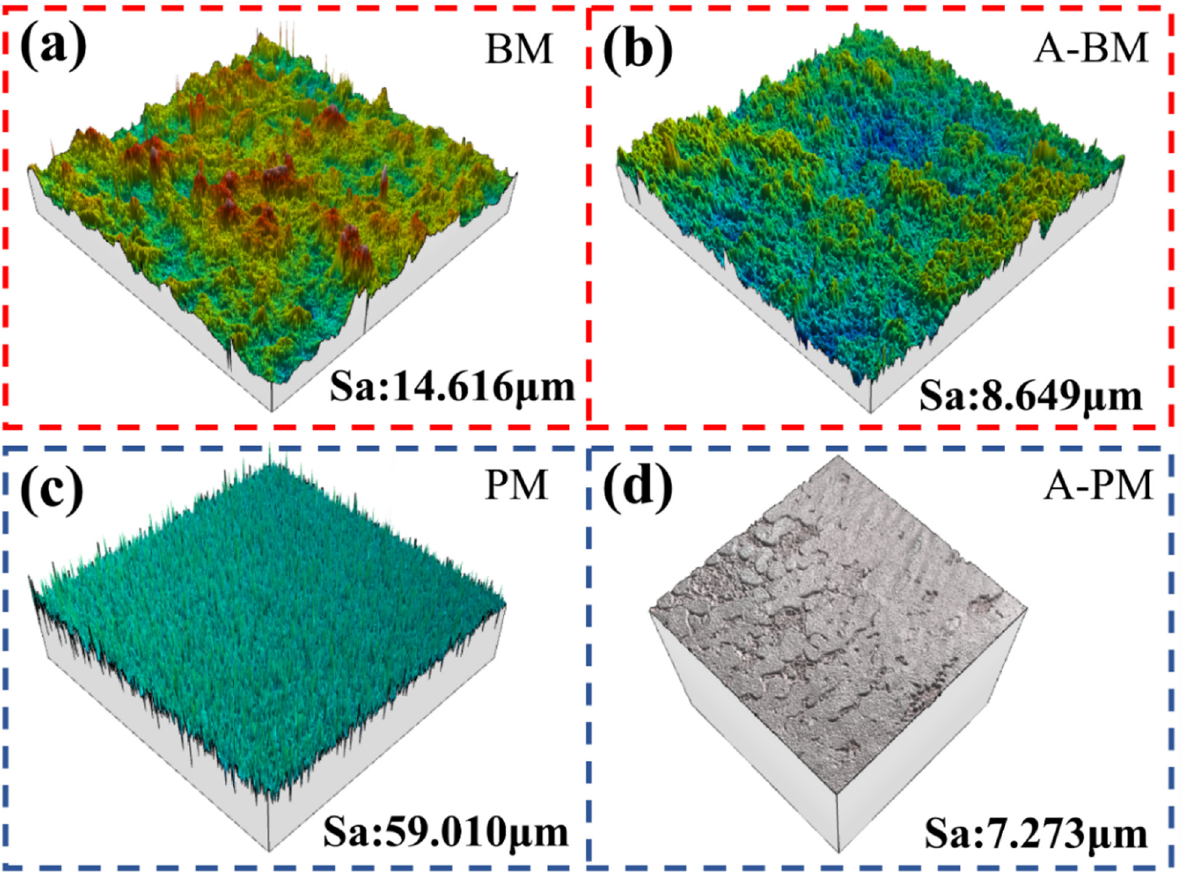
Figure 8. Three-dimensional morphology of ( a ) BM surface, ( b ) aged BM surface, ( c ) PM surface, and ( d ) aged PM surface.